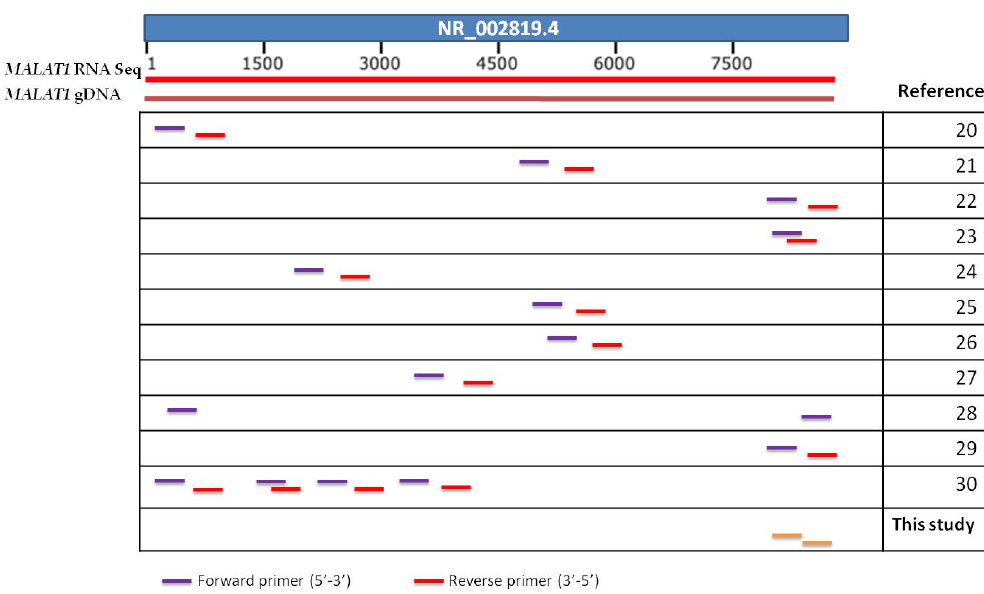
Figure 1. Graphic summary of lncRNA MALAT1 reference sequence, MALAT1 gDNA and position of different pairs of primers designed used in various studies. The last pair (green) was the one designed in the present study. Table 2. MALAT1 expression in cancer.